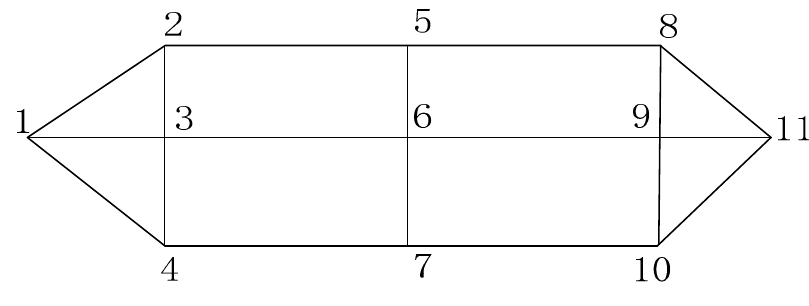
Figure 2. Simple taxiway network diagram.